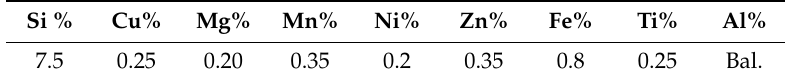
Table 1. Chemical composition of aluminum alloy A356.